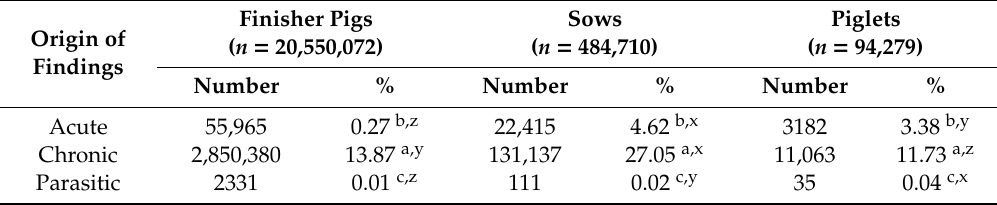
Table 3. Comparison of the number of individual patho-anatomic findings in kidneys in finisher pigs, sows and piglets slaughtered in the slaughterhouses.